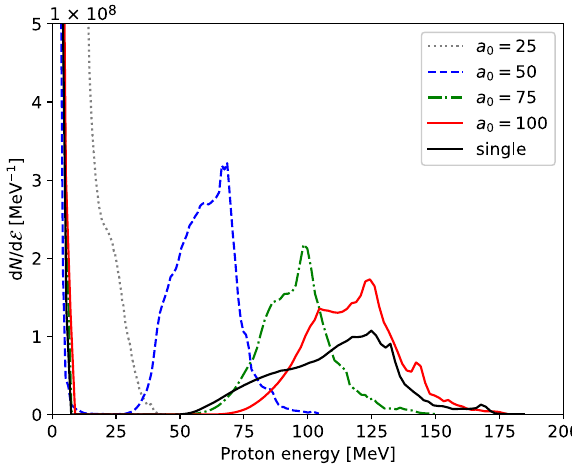
FIG. 3. Obtained proton energy spectra for different laser vector